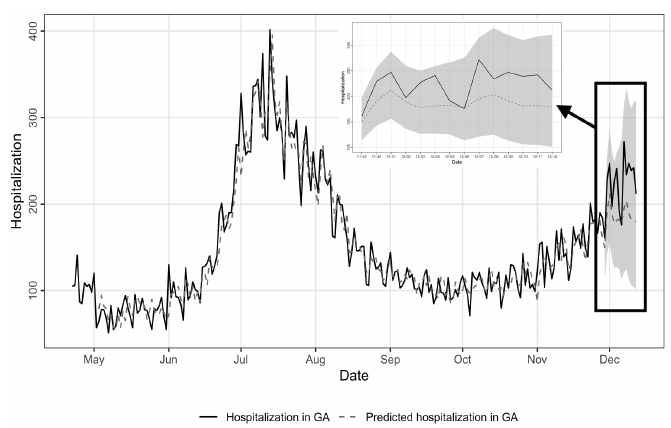
Figure 2. Epidemic curve of measured daily incident COVID-19- related hospitalizations and C19Check-predicted COVID-19 related hospitalizations from April 22–December 12, 2020 in the state of Georgia. The upper and lower confidence intervals (gray shading) from the fitted VAR model with a time-lag of 11 days are depicted from November 29–December 12,